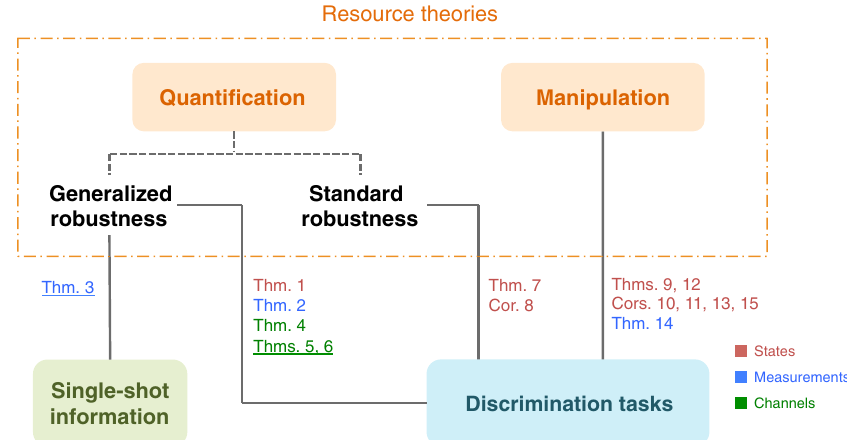
FIG. 1. Schematics showing the connections established by the results in this work. The colors of the theorem labels indicate the types of resources relevant to the results (red, states; blue, measurements; green, channels). The underlined theorems (Theorems 3, 5, and 6) are shown specifically for quantum theory, while the other results are valid in general